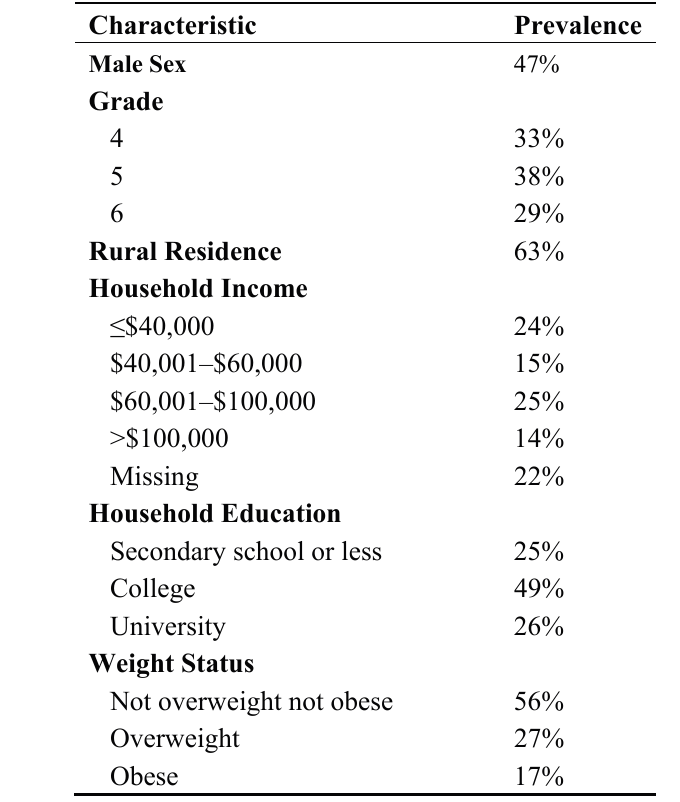
Table 1. Sociodemographic characteristics and weight status of the 535 children in the study.